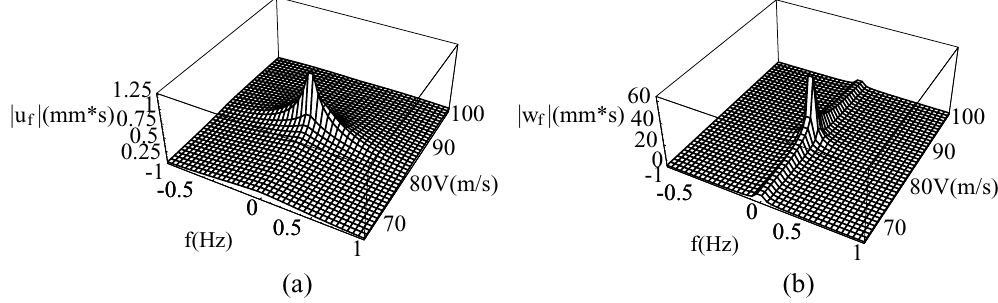
Fig. 5. The amplitude spectra depending on frequency and velocity for: (a) the horizontal component, (b) the vertical component.